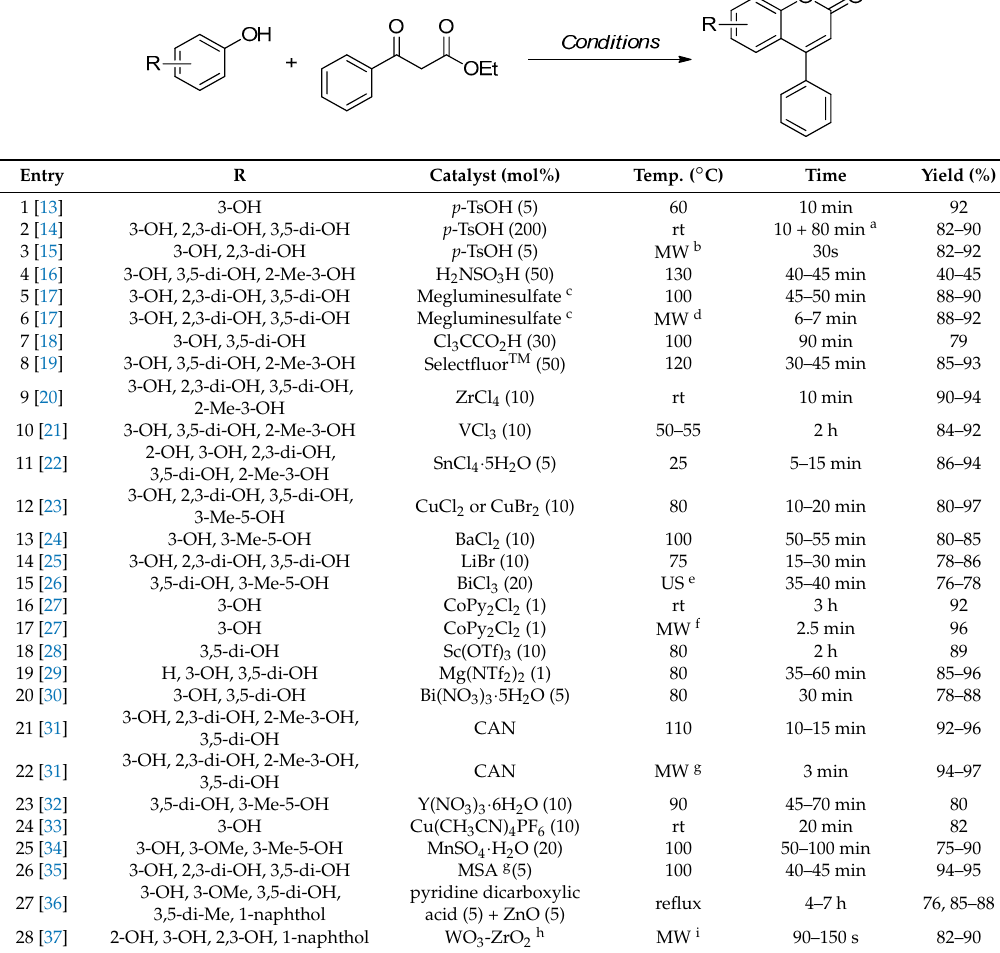
Table 1. Solvent-free Pechmann condensation for the synthesis of 4-arylcoumarins.